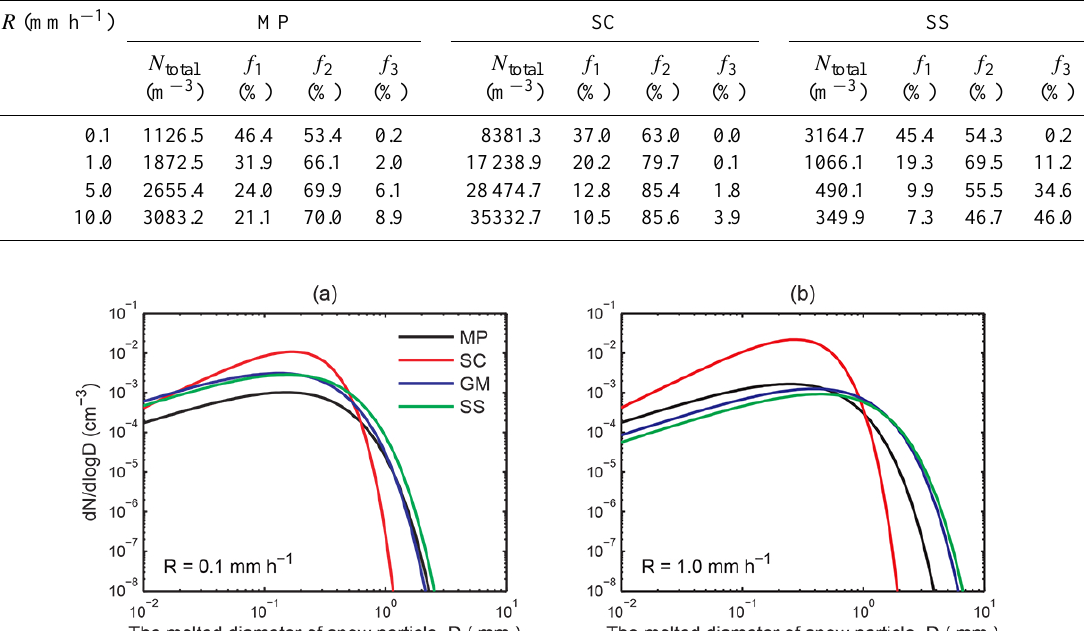
Table 5. Total snow-particle number concentration ( N total , m − 3 ) for three of the number size distributions listed in Table 2 for four different snowfall intensities (as liquid water equivalent). MP denotes the Marshall and Palmer (1948) distribution, SC the Scott (1982) distribution, and SS the Sekhon and Srivastava (1970) distribution. f 1 , f 2 , and f 3 are the percentages of the snow particles with equivalent melted